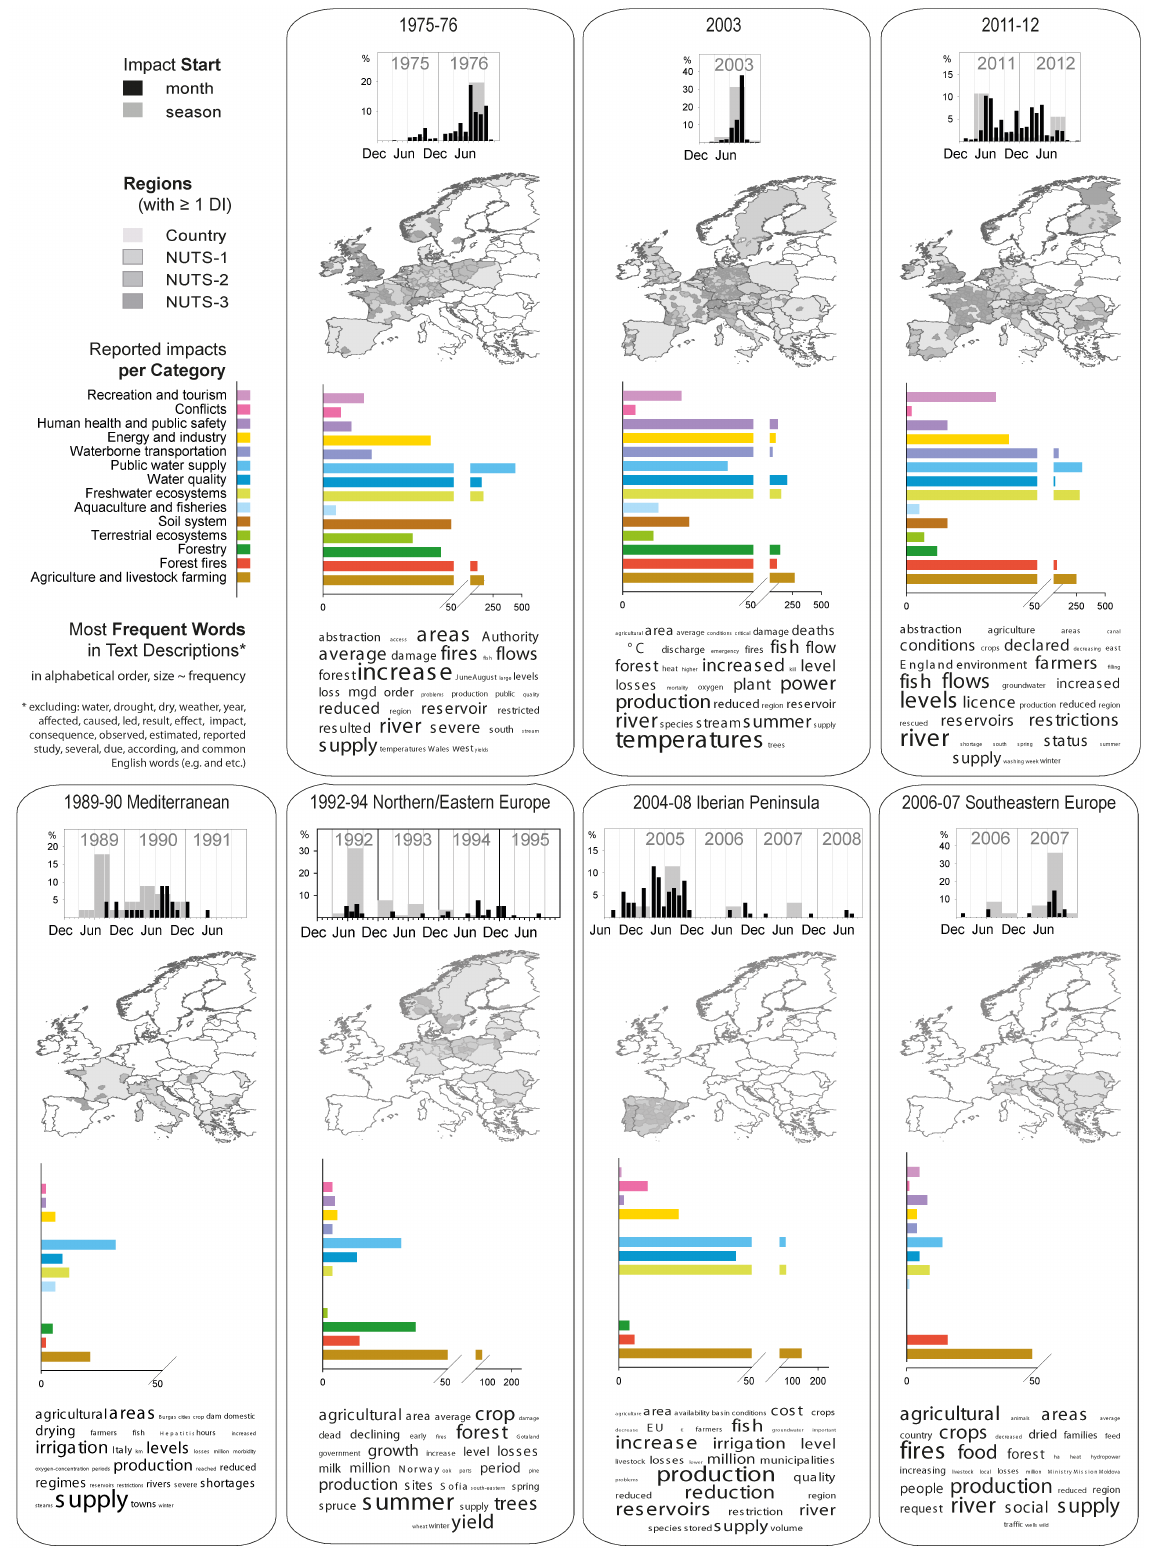
Figure 5. Reported drought impacts for selected European drought events during the period 1970–2013. For each event, the following characteristics are shown (up to down panels): temporal distribution of reported impact starts, geographical location of reported impacts, number of impacts per category, and most frequent words in text descriptions (word clouds generated with